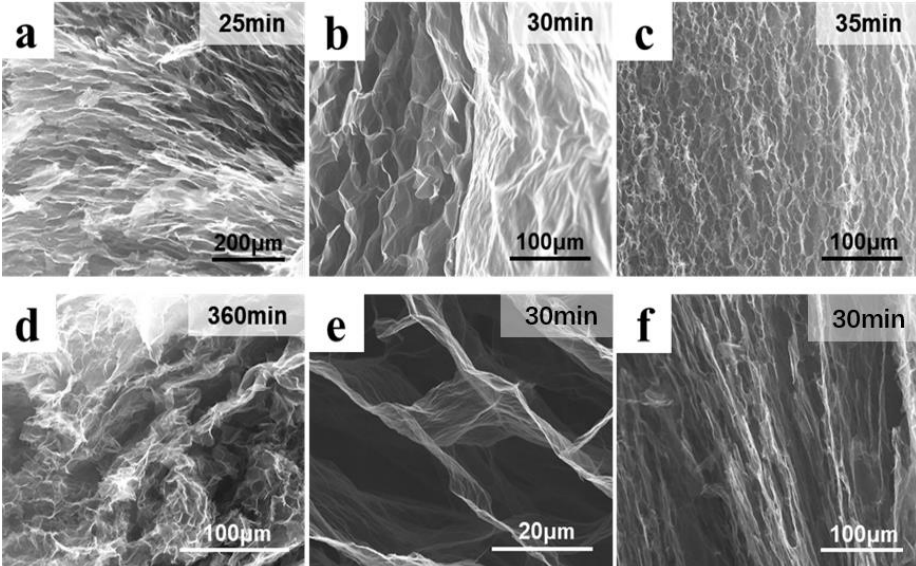
Figure 6. The micromorphology of graphene gel prepared in diffident conditions: ( a ) hydrothermal reduction of 25 min; ( b ) hydrothermal reduction of 30 min; ( c ) hydrothermal reduction of 35 min; ( d ) hydrothermal reduction of 360 min; ( e ) cross section of VAG90 − 30; ( f ) longitudinal section of VAG90 − 30.